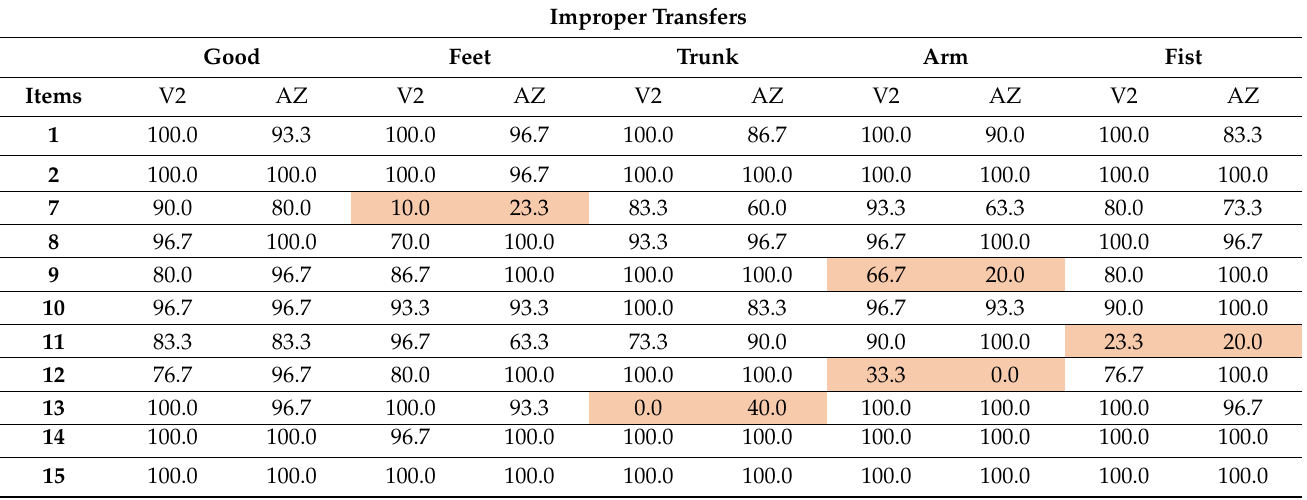
Table 8. Percent accuracy of ML outcomes from Azure (AZ) and V2 compared to ground truth (30 trials of each transfer type). The shaded cells indicate the items that were targeted for each improper transfer type and